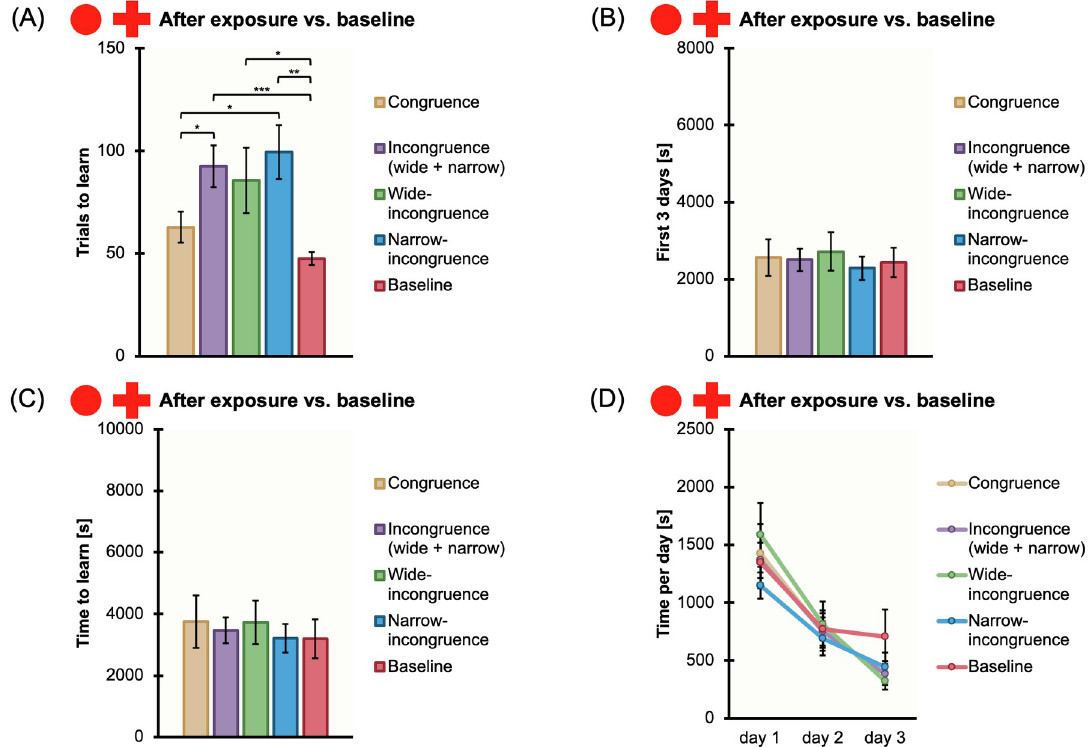
Fig 7. Comparison among conditions and experiments. The bar charts show all the comparisons among the congruence and incongruence conditions of Experiment 2 (full red disk vs. red cross discrimination learning after exposure), and the comparison between Experiment 2 and the baseline of Experiment 3 (full red disk vs. red cross discrimination learning without exposure), for the four variables measured: The mean number of trials to learn the discrimination, “Trials to learn” (A); the total amount of time spent, in seconds, during the experimental trials to exit the arena, considering the first 3 days of training, “First 3 days” (B); the total amount of time spent, in seconds, during the experimental trials to exit the arena, considering all the trials needed to meet the learning criterion, “Time to learn” (C); the time spent, in seconds, during the experimental trials to exit the arena, considering the first 3 days of training separately, “Time per day” (D).Mean ± SEM are shown; asterisks indicate statistically significant differences ( p �